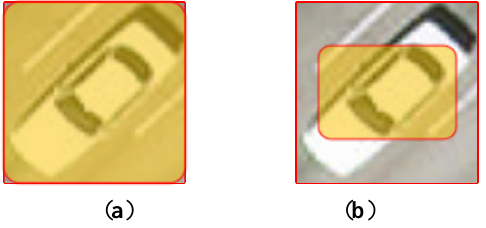
Figure 3. Sampling method. ( a ) FCOS sampling, ( b ) FoveaBox sampling.